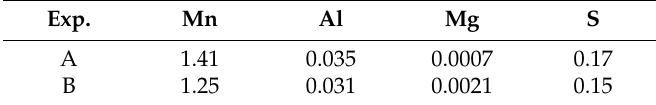
Table 2. Chemical compositions of steels in different experiments (mass